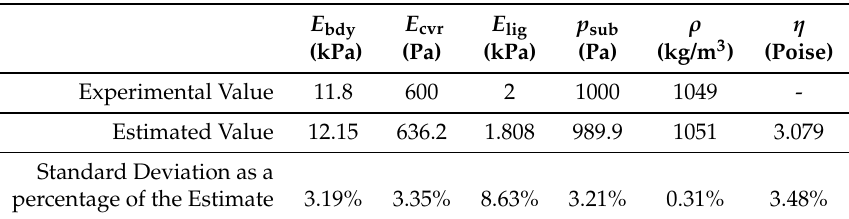
Table 3. Material property estimates for the case without medial